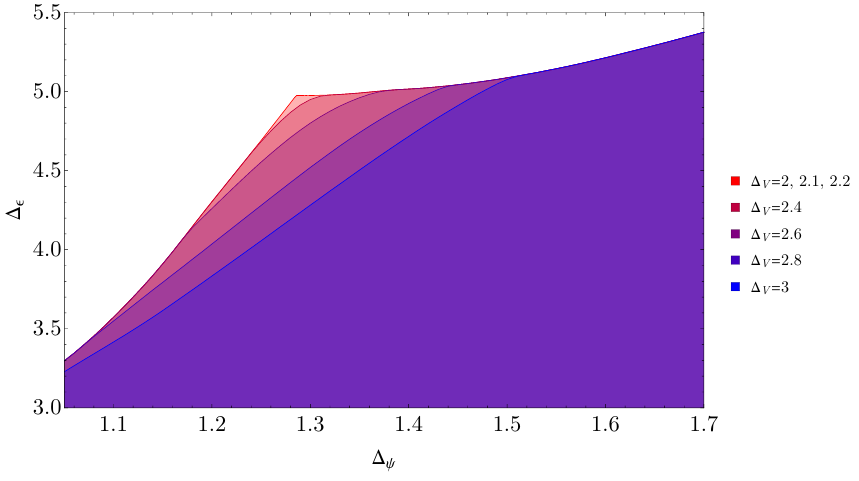
in the parity-even scalar sector at Λ = 27 for various Figure 4 : The bound on the gap ∆ (cid:15) values of the gap ∆ ∈ [2 , 3]. The gaps are listed on the right in the same order as the V curves appear in the plot, top to